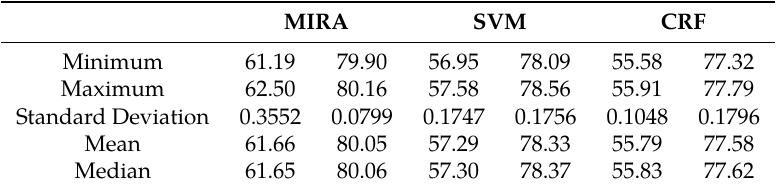
Table 18. Measure of